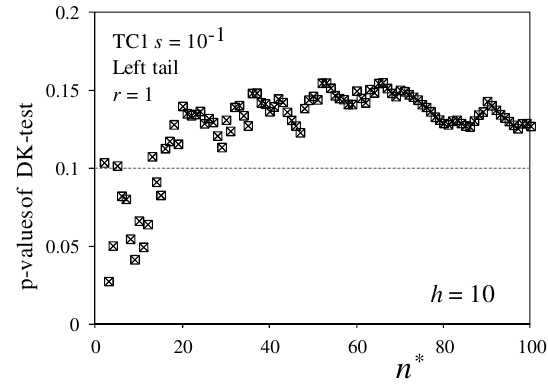
Fig. 8. U test p values for TC4 at (a) s = 10 − 2 and (b) s = 10 − 1 .